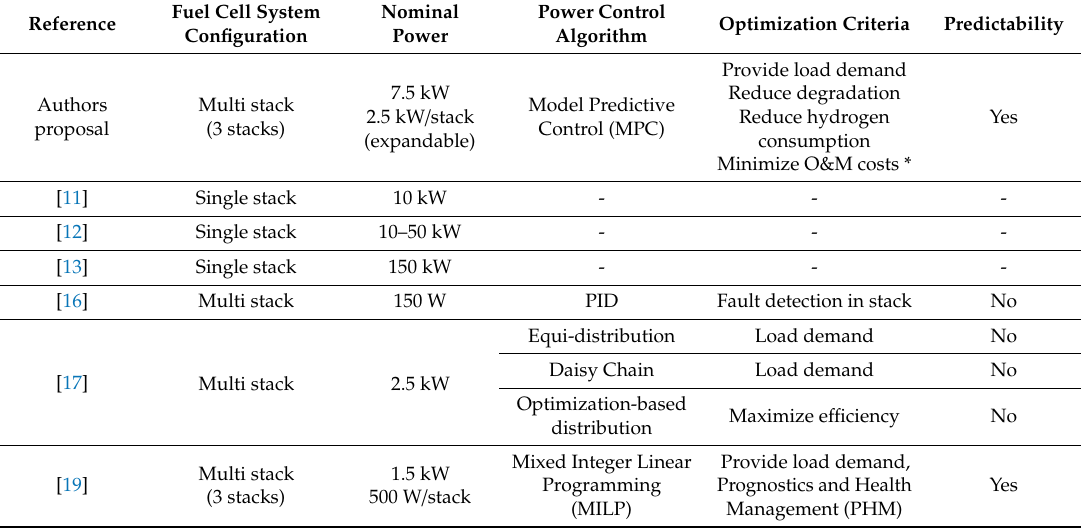
Table 1. Comparison of the findings of the proposed paper with previous scientific